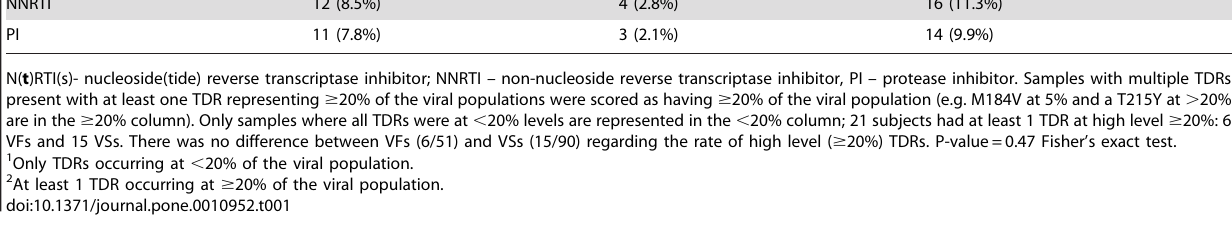
WHO TDR Mutation Class